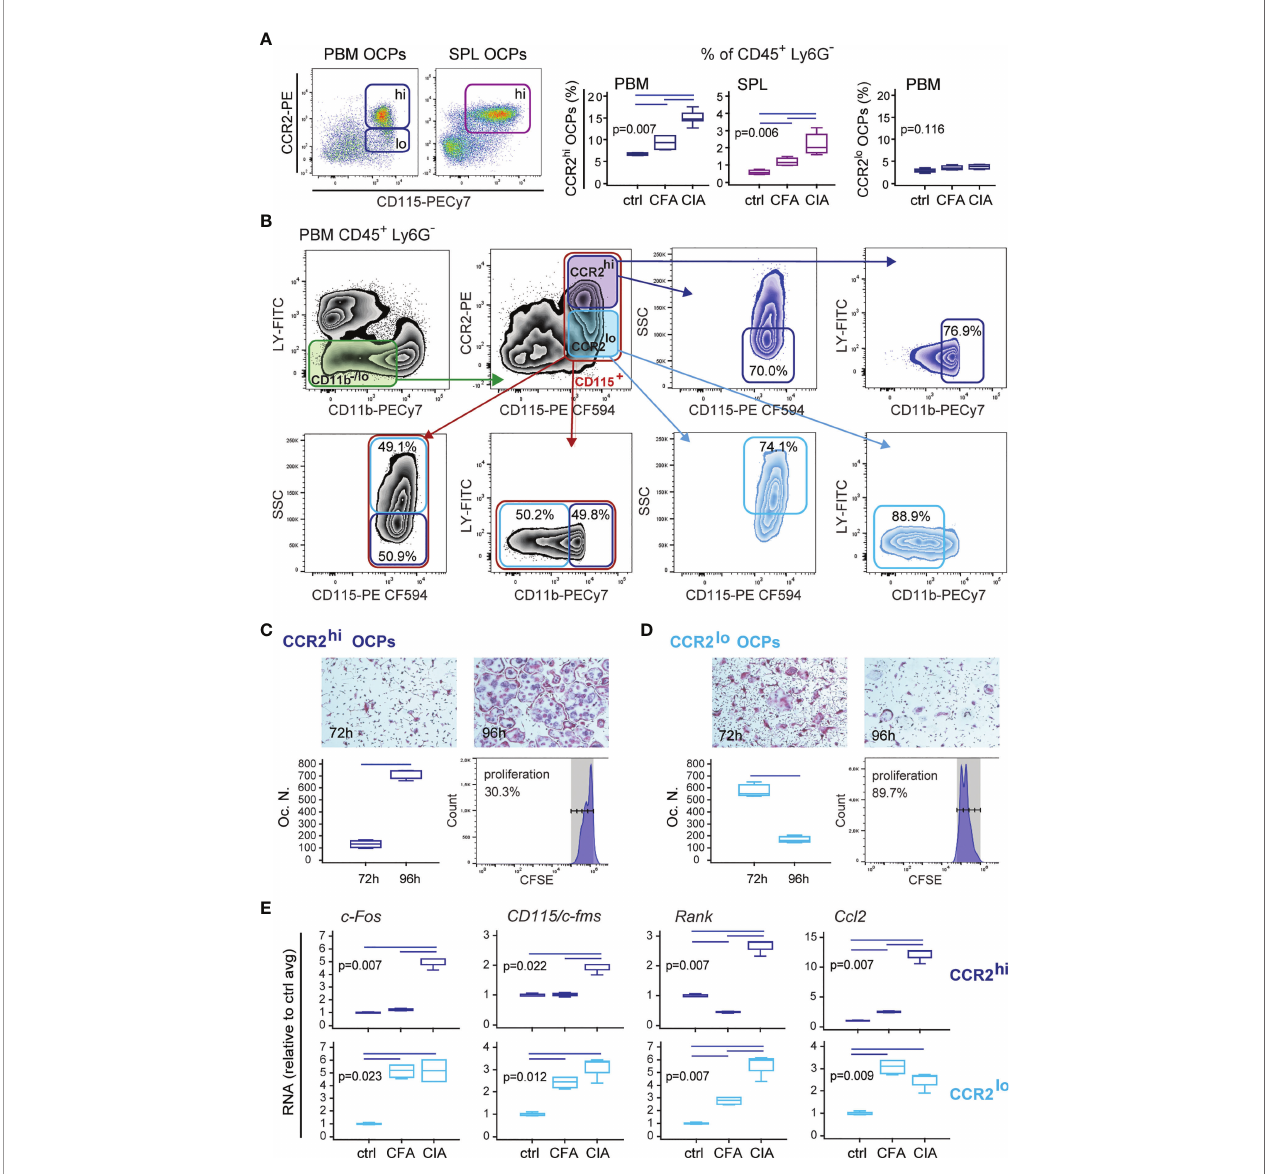
FIGURE 3 | Properties of CD45 + CD3 - B220 - NK1.1 - Ly6G - CD11b -/lo CD115 + CCR2 hi (CCR2 hi ) and CD45 + CD3 - B220 - NK1.1 - Ly6G - CD11b -/lo CD115 + CCR2 lo (CCR2 lo ) osteoclast progenitor (OCP) subpopulations in B6 mice with collagen-induced arthritis (CIA). (A) Frequency of CCR2 hi and CCR2 lo OCPs in periarticular bone marrow (PBM) and spleen (SPL) in control (ctrl), complete Freund ’ s adjuvant treated mice (CFA), and arthritic mice (CIA). Representative dot plots are shown. (B) Representative fl ow cytometry data of the properties of CCR2 hi and CCR2 lo OCPs in arthritic PBM. Greater proportion of CCR2 hi cells is of lower SSC signal and CD11b low positive. Greater proportion of CCR2 lo cells shows higher SSC signal than CCR2 hi cells and is CD11b negative. Red gate — total CD115 + cells; dark blue gate — CCR2 hi subset; light blue gate — CCR2 lo subset. (C, D) Proliferative and osteoclastogenic potential of CCR2 hi (C) and CCR2 lo (D) subpopulations. Sorted cells were stimulated for 72 h and 96 h by receptor activator of nuclear factor k B ligand (RANKL) and macrophage colony-stimulating factor (M-CSF) in culture plates at the same density (7,000 cells/well). Representative microphotographs of in vitro differentiated tartrate-resistant acid phosphatase (TRAP) + osteoclast-like cells are presented (magni fi cation 100×). Differentiated TRAP + multinucleated osteoclast-like cells were counted per well (Oc.N.). For proliferation assay, sorted cells were stained with carboxy fl uorescein diacetate succinimidyl ester (CFSE) before culturing for 2 days with RANKL and M-CSF, and fl ow cytometric analysis. (E) qPCR analysis of c-Fos, CD115/cFms, Rank , and Ccl2 gene expression levels in sorted CCR2 hi and CCR2 lo progenitor subpopulations after culturing with RANKL and M-CSF for 2 days, presented as relative quantity of RNA in ctrl, CFA, and CIA mice, and normalized to the average value of control group (ctrl avg). The experiments were repeated three times and pooled data are shown ( n = 6 – 10 mice per group). Values are presented as medians (middle horizontal lines), boxes represent the interquartile range (IQR), whiskers represent 1.5 times the IQR. Statistically signi fi cant difference was determined at p < 0.05, Mann – Whitney U -test (C, D) , Kruskal – Wallis test ( p -value marked on the graph) with Conover post-hoc test for group-to-group comparisons (A, E) ; correction for multiple comparisons (E) was performed using Holm – Bonferroni method; line denotes signi fi cant difference between groups. CD115/cFms — colony stimulating factor 1 receptor ( Csf1r ), Rank — receptor activator of nuclear factor k B, LY —